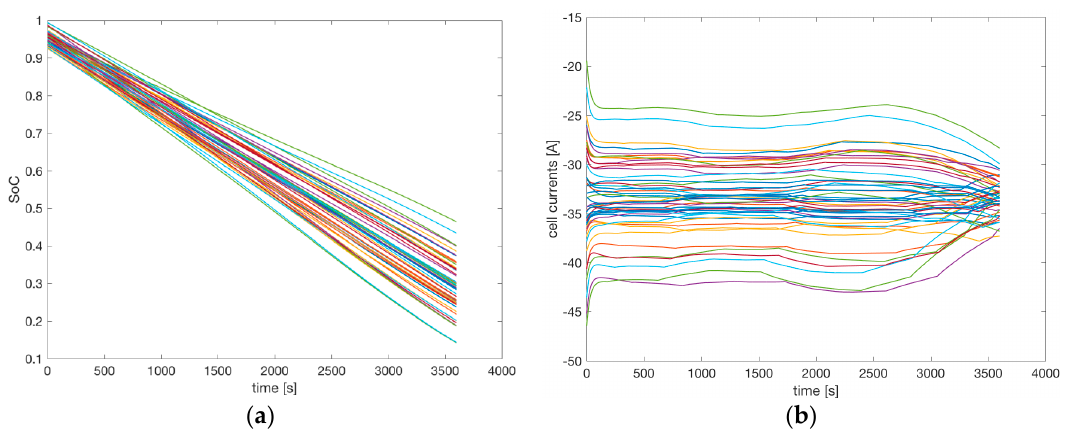
Figure 12. ( a ) SoC of the 48 cells; ( b ) current driven from each cell. Energies 2017 , 10 , 375